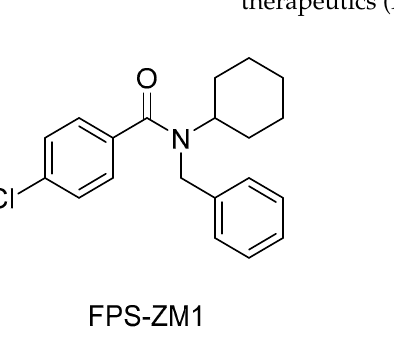
Figure 6. Structures of some of the RAGE inhibitors that are in clinical development.